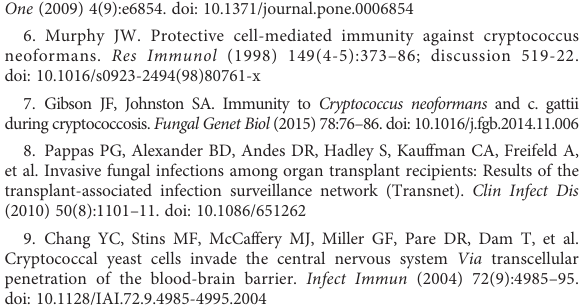
SUPPLEMENTARY FIGURE 5 No Differential Macrophage Activation or Th1/Th2 Bias among the Cells. Processed human BAL cells were enriched for phagocytic APCs and incubated with C. neoformans strain H99 for 2h and then processed for